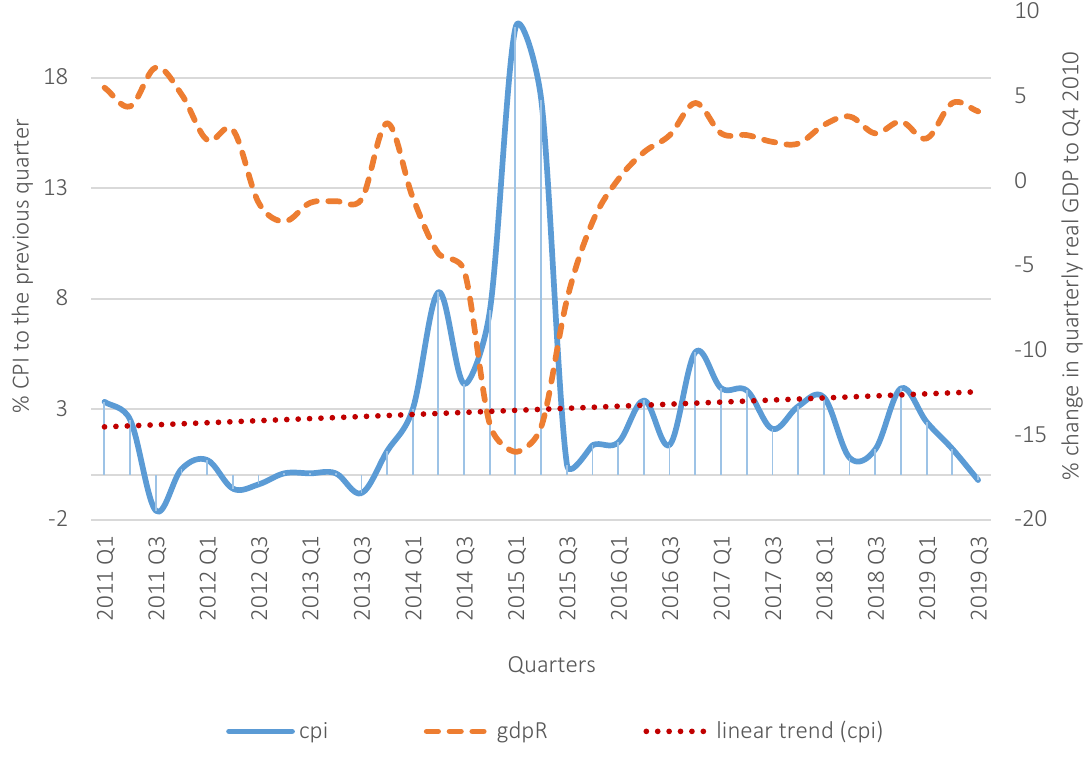
Figure 1. Real GDP ( gdpR ) and consumer price index ( cpi ) in Ukraine, 2011 Q1 – 2019 Q4 Table 2. The correlation matrix between GDP and CPI variables of the Ukrainian